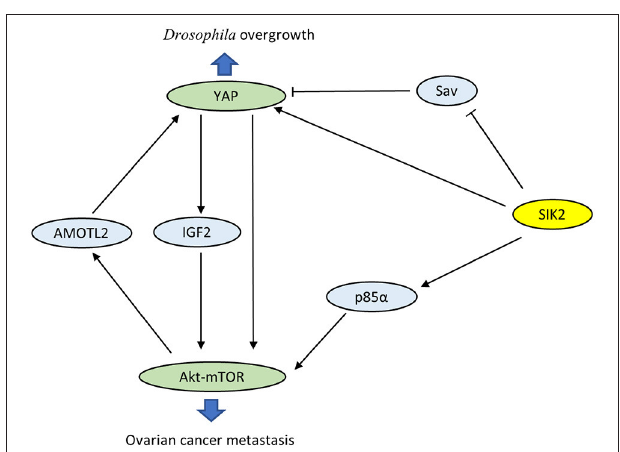
FIGURE 2 | Crosstalk between the PI3K-Akt-mTOR pathway and the Hippo-Yap pathway via SIK2.